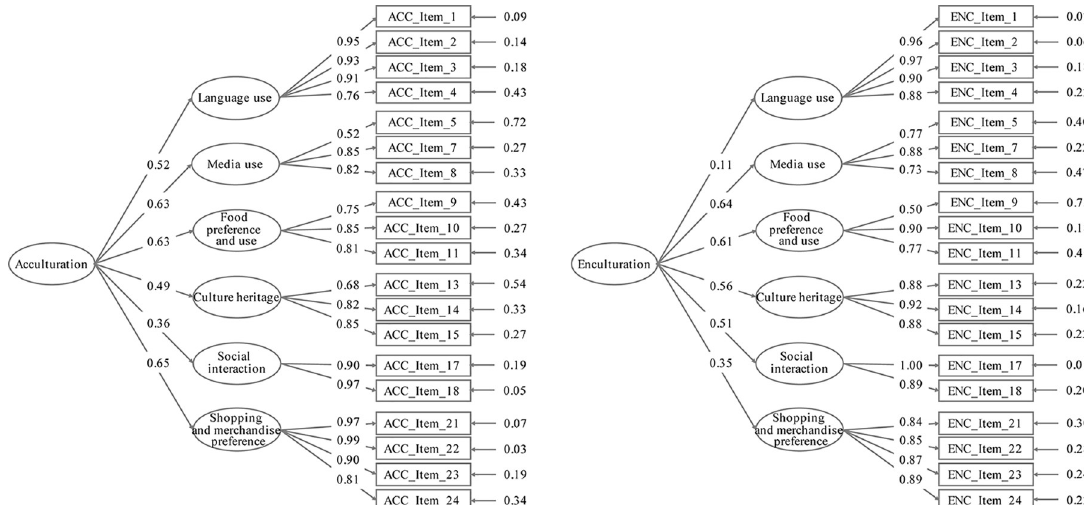
Fig 1. Confirmatory factor analysis for the acculturation and enculturation subscales: Standardized factor loadings and error variances for the second-order six-factor model (N = 310). https://doi.org/10.1371/journal.pone.0258323.g001 Means, standard deviations, and inter-correlations of the six-domain and total scores for the two subscales of bidimensional acculturation are presented in Table 3. The six domains correlated well with the overall acculturation and enculturation scores. The only insignificant association occurred between language use and social interaction ( r = 0.08) in the accultura- tion subscale. There were three insignificant associations: between language use and food pref- erence and use ( r = − 0.004), language use and social interaction ( r = 0.03), media use and food preference and use ( r = 0.10) in the enculturation subscale. The significant correlation Table 3. Means and inter-correlations of the six-domain and total scores for acculturation subscale and enculturation subscale.